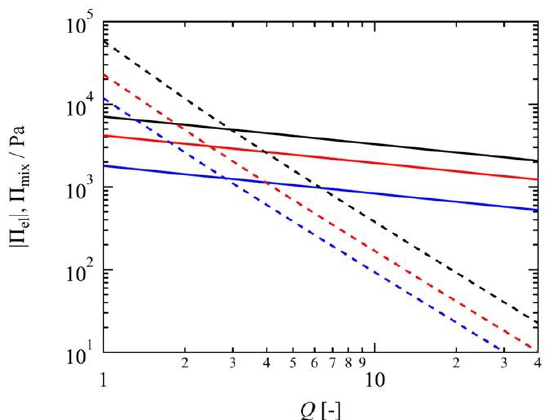
Figure 5. The absolute value of elastic pressure |Π el | (solid lines) and mixing pressure Π mix (dashed lines) of the 10 K (blue), 20 K (red), and 40 K (black) Tetra-PAA-PEG gels as a function of the swelling ratio Q.